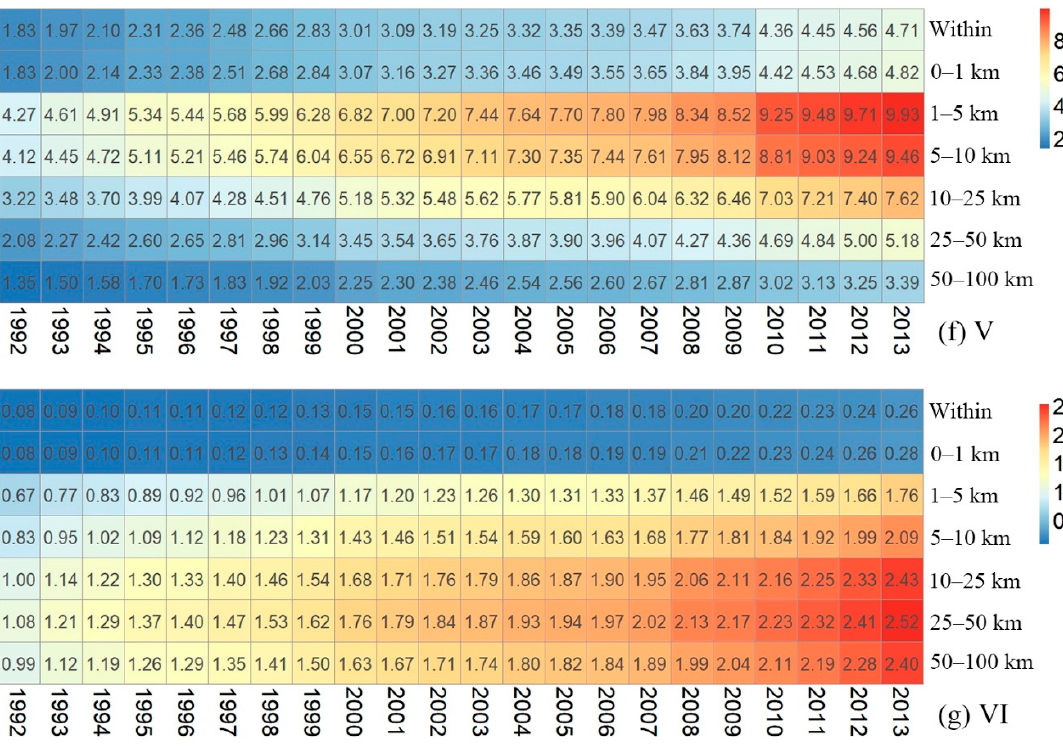
Figure 8. Changes within PAs and in different buffer zones in the NTL level of different types of PAs in the time series. The numbers in the grid represent the average NTL DN values. The color of the grids is from blue to red, and the corresponding values are from small to large. ( a ) strict nature reserve (Ia), ( b ) wilderness area (Ib), ( c ) national park (II), ( d ) natural monument or feature (III), ( e ) habitat/species management area (IV), ( f ) protected landscape/seascape (V), and ( g ) protected area with sustainable use of natural resources (VI).